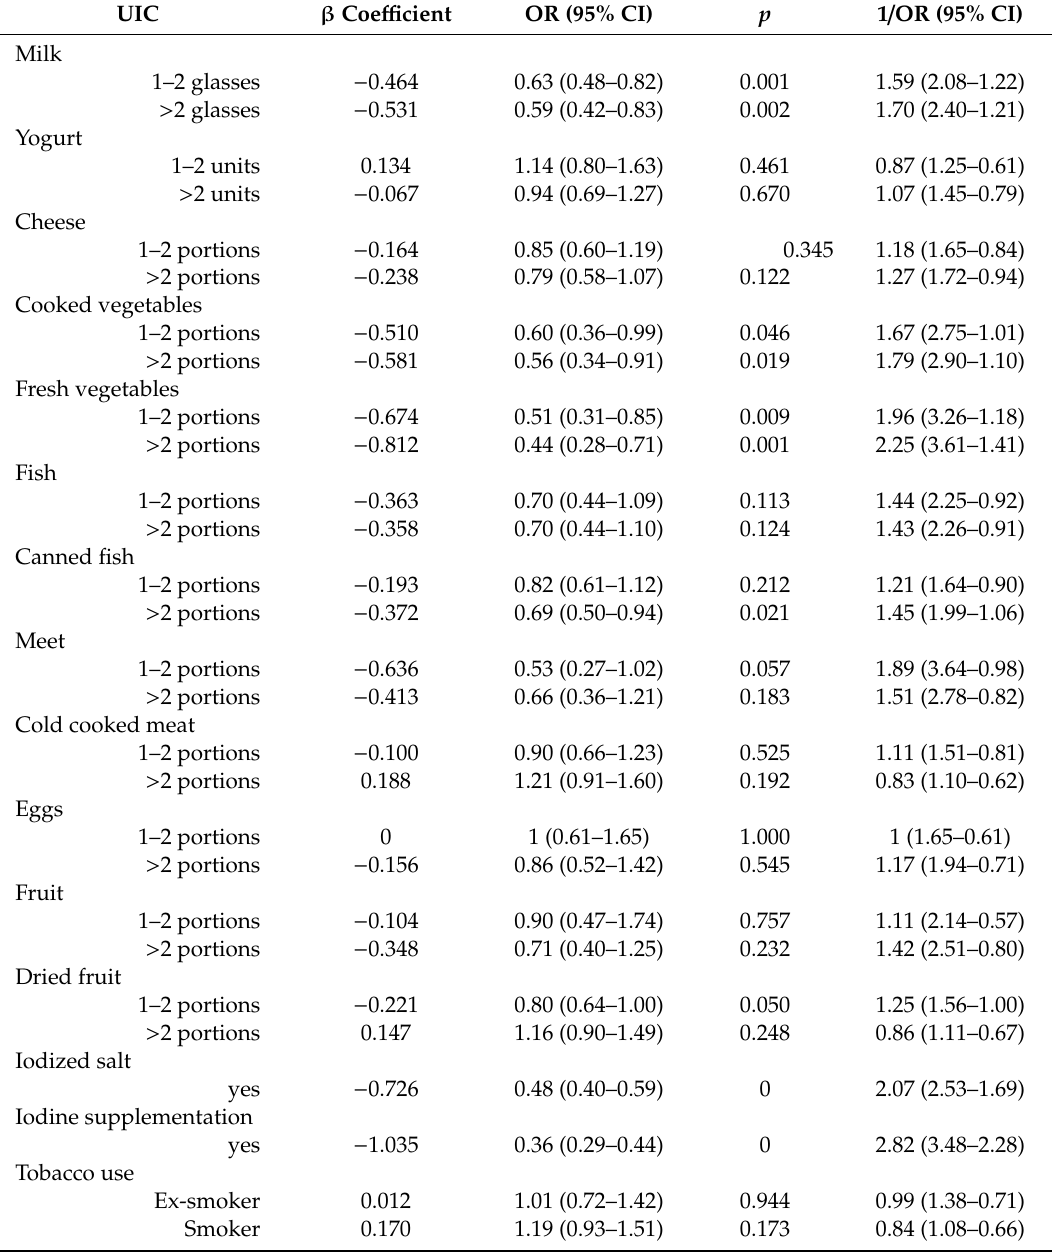
Table 3. Individual e ff ects of each variable included in multilevel mixed-e ff ects logistic regression models adjusted for paired measures in the 3 trimesters to assess the e ff ect of iodine-rich food intake or supplementation on UIC values < 150 µ g /